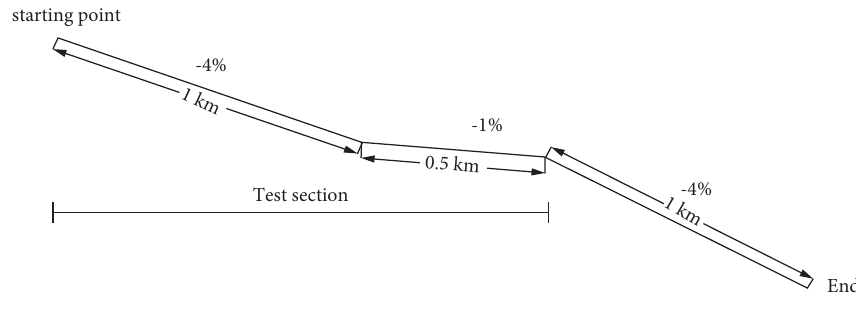
Figure 1: Experimental road alignment. Table 1: Values of factor